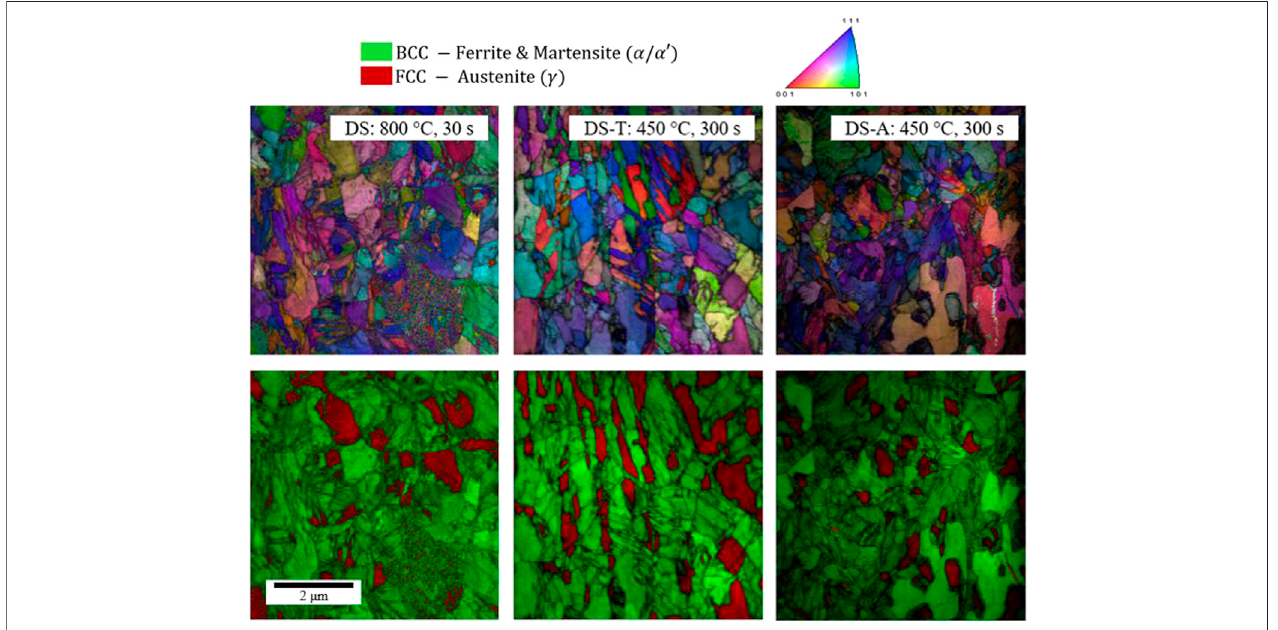
FIGURE 9 | (A) Engineering stress-strain and (B) true work hardening rate as a function of true stress for the DS-A 0.14C-7.17Mn steel following austempering at 450 ° C for 30 or 300 s. The plastic instability criterion (d σ /d ε (cid:2) σ ) is indicated by the dashed line.